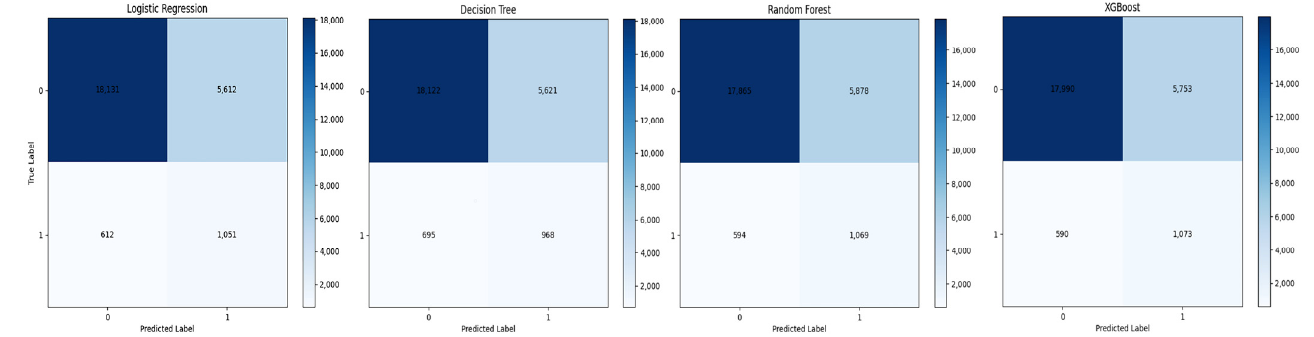
Figure 3. The confusion matrix of the four machine learning models. Table 3. Comparison of performance of the four machine learning models.